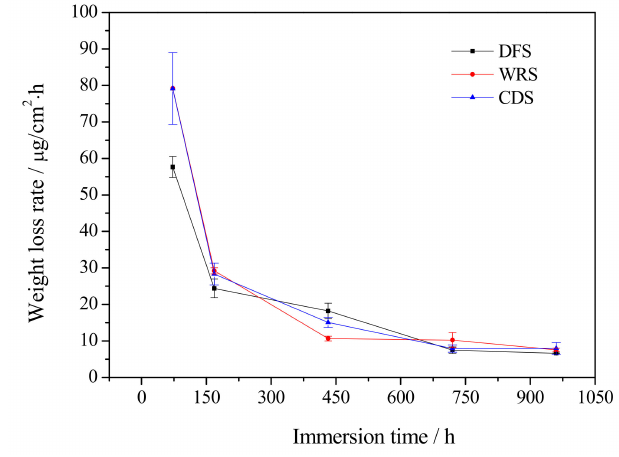
Figure 4. The weight loss rate of DFS, WRS and CDS immersed in 3.5% NaCl solution for di ff erent times.